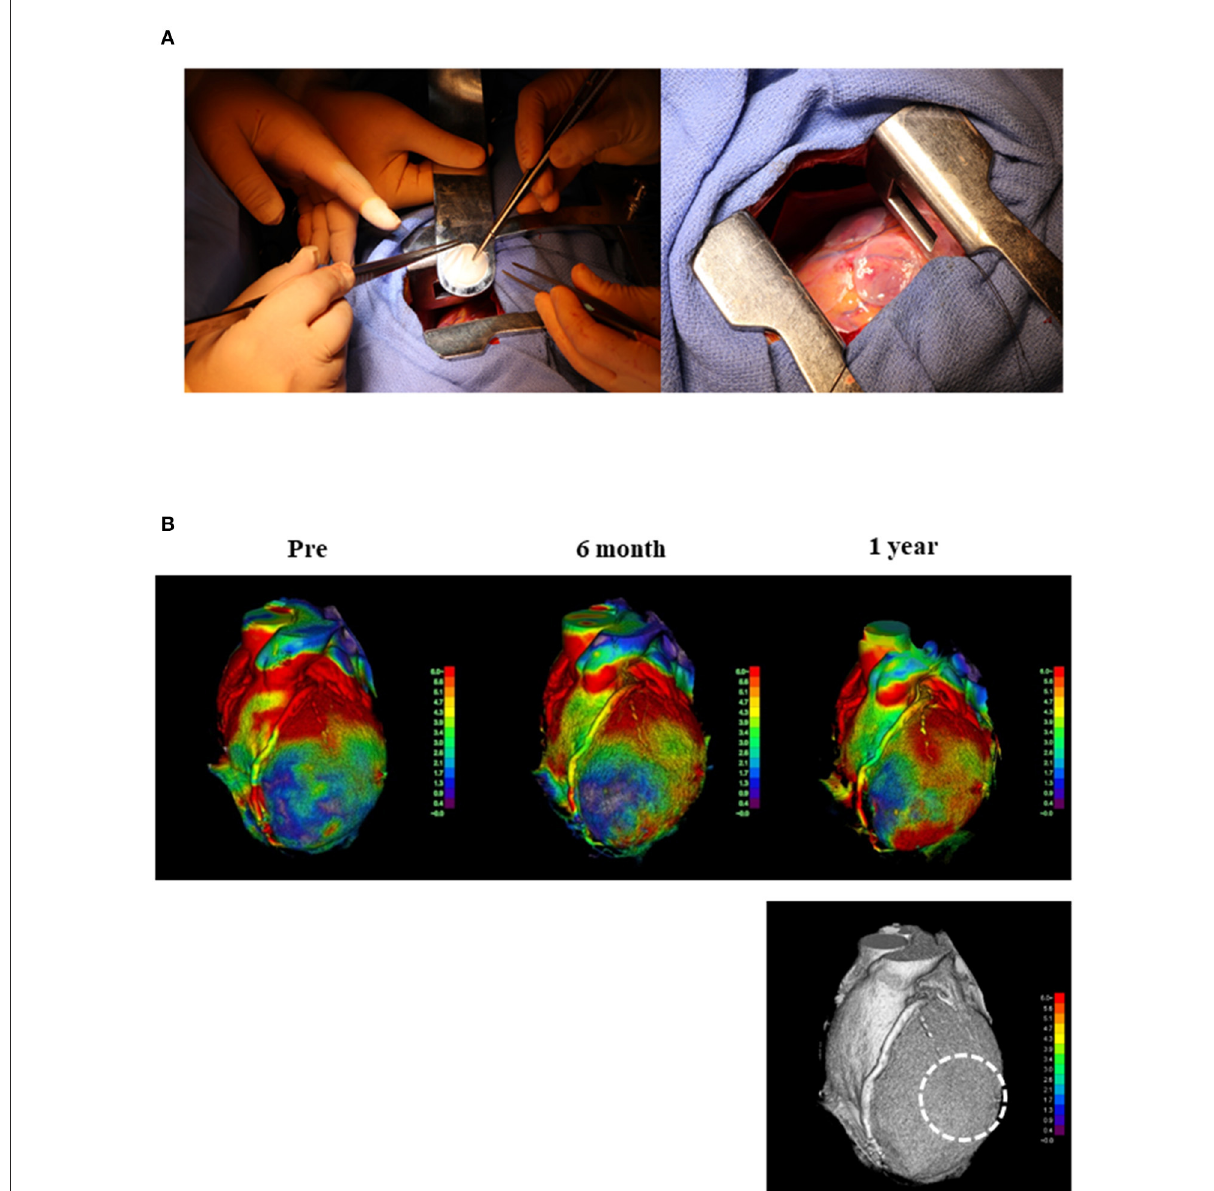
FIGURE2 Transplantation of hiPSC-CM and cardiac moving pattern before and after surgery. (A) First transplantation of hiPSC-CM patches onto the heart surface of a patient with severe cardiomyopathy. Left: hiPSC-CM patch was transplanted into the epicardium of the anterior and lateral walls of the LV through the fourth intercostal space under IABP support. Right: Three patches were transplanted into the epicardium of the LV anterior and lateral walls. (B) The moving pattern observed via four-dimensional CT. Colors were set so that red indicated a good dynamic area; the darker the color, the lower the movement. The images show the moving pattern in chronological order of the heart at pre-implantation (pre), 6 months, and 1 year after implantation. The dotted line in the bottom figure shows the area where the patches were attached. hiPSC-CM, human induced pluripotent stem cell-derived cardiomyocyte; LV, left ventricle; IABP, intra-aortic balloon pumping; CT, computed tomography.